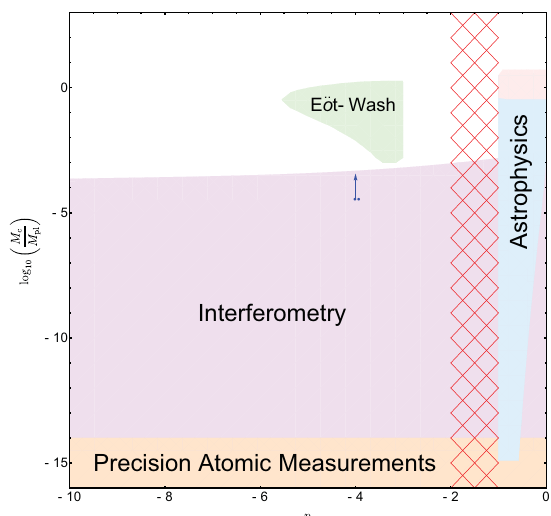
Figure 2. Current bounds on the parameters n and M c when (cid:8) is fixed to the dark energy scale and n < 0. The red hashed region indicates values of n where the model is not a chameleon, and the reader is reminded that only negative even integers are chameleons. The coloured regions are excluded. The region labeled astrophysics contains bounds from both Cepheid and rotation curve tests. The purple region, labeled interferometry, shows the constraints from atom interferometry. The blue arrow indicates the lower bound coming from the neutron interferometry experiment of [33]. This figure first appeared in